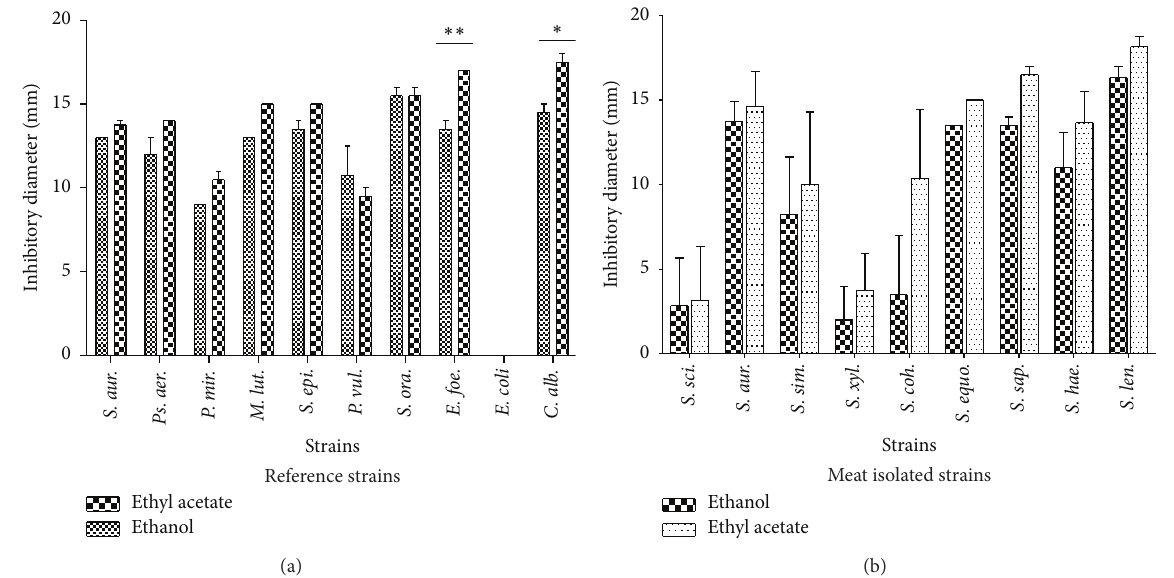
Figure 3: Comparison of medium inhibitory diameter of C. nitida ’s ethyl acetate extract and ethanol extract on reference strains and meat isolated Staphylococcus strains. Reference strains are the following: S. aur. : Staphylococcus aureus , M. lut. : Micrococcus luteus , S. epi. : Staphylococcus epidermidis , S. ora. : Streptococcus oralis , Ps. aer. : Pseudomonas aeruginosa , P. vul. : Proteus vulgaris , E. coli : Escherichia coli , C. alb. : Candida albicans , P. mir. : Proteus mirabilis ; meat isolated strains are the following: S. sci. : S. sciuri , S. aur. : S. aureus , S. sim. : S. simulans ,